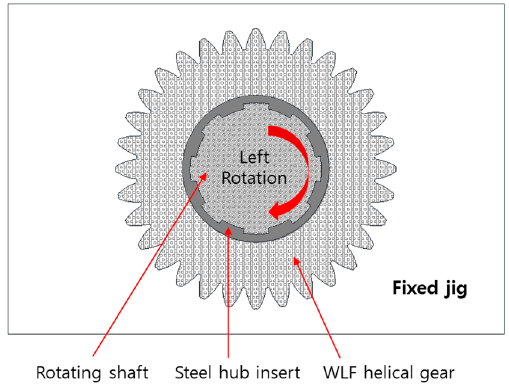
Figure 6. Schematic of the torsional strength test.